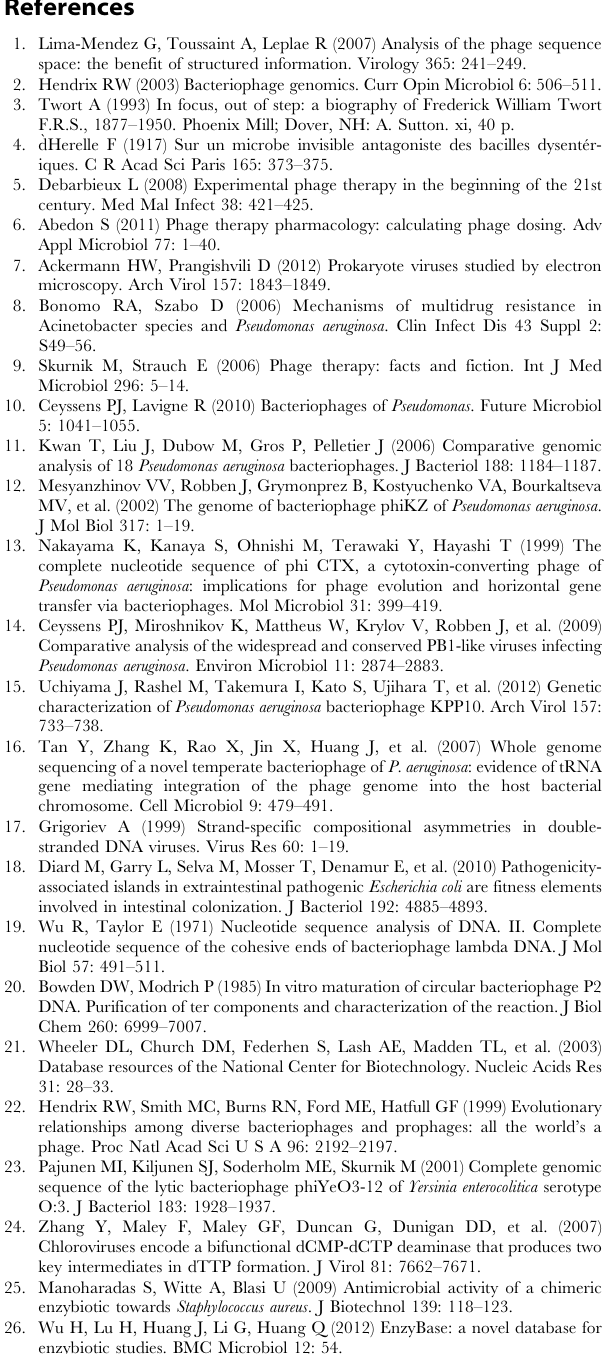
Table S1 Predicted genes and proteins of phage